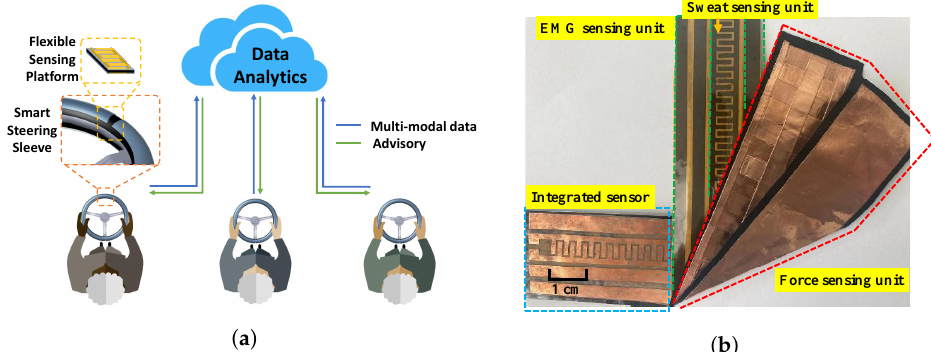
Figure 1. Overview of the developed cloud-based smart steering sleeve system: ( a ) schematic of the sensor and cloud-based data analytics; and ( b ) integrated multi-modal sensor